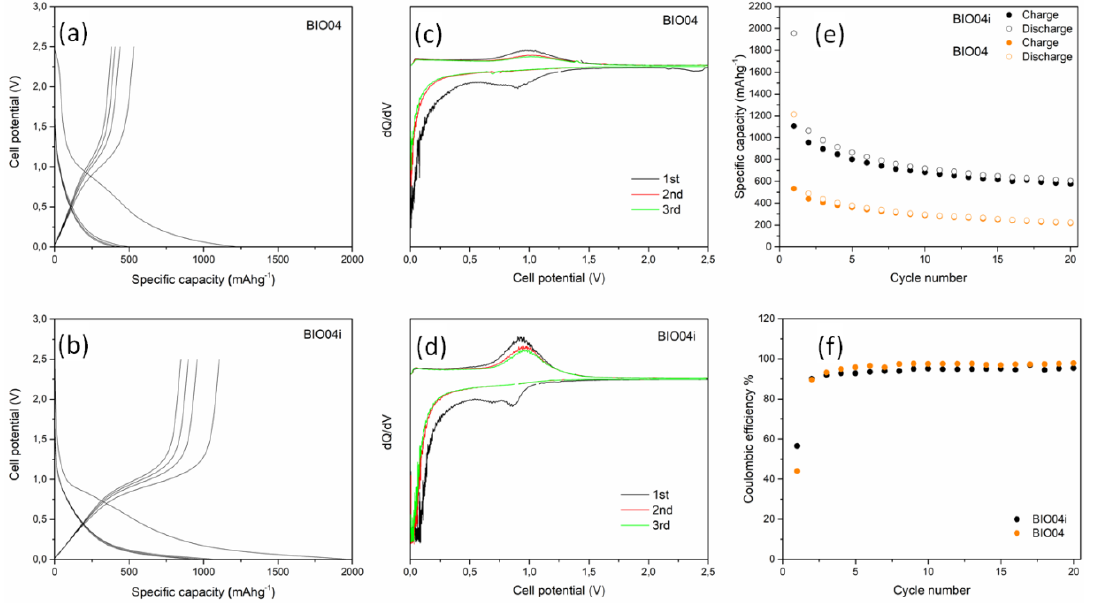
Figure 7. Voltage profile for the first cycles of ( a ) BIO04 and ( b ) BIO04i; Capacity derivative vs. voltage for the first 3 cycles of ( c ) BIO04 and ( d ) BIO04i; galvanostatic cycling performances in terms of specific capacity ( e ) and coulombic efficiency ( f ) of electrodes cycled at 10 mAg −1 .